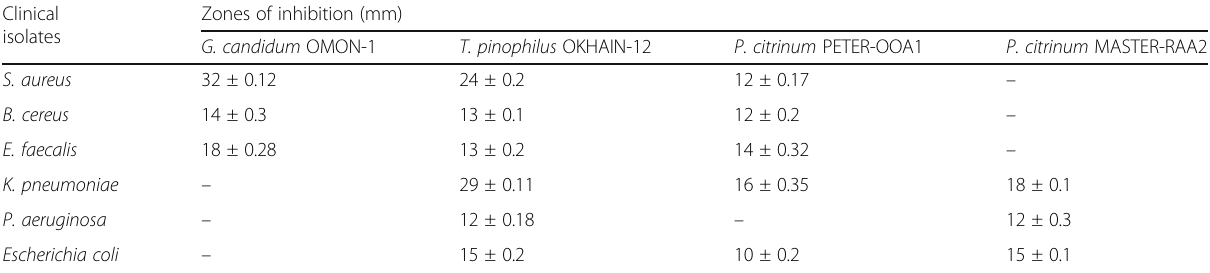
Table 2 Antibacterial activity of bioactive extracts of fungi strains screened from pharmaceutical waste sludge Clinical